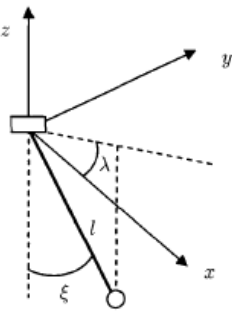
Figure 2: Owe drive axle simplified model of the